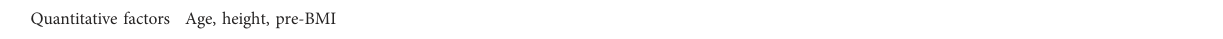
TABLE 2 Static factors.